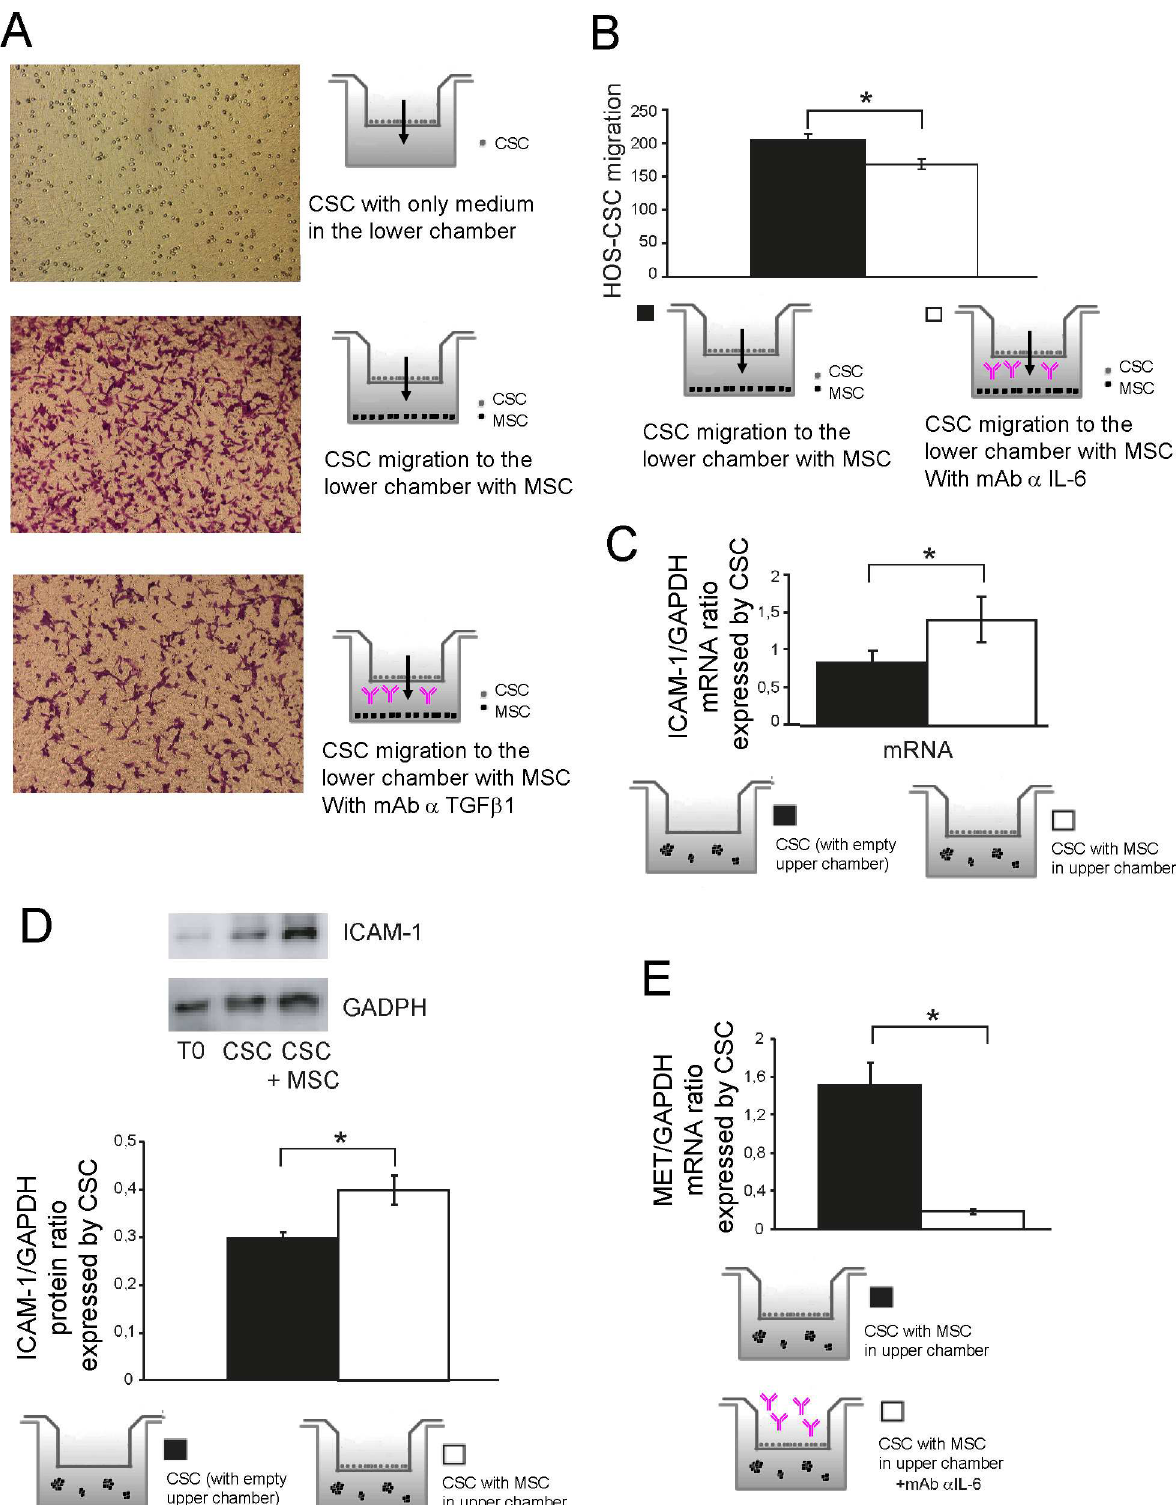
Fig 8. Stromal cells enhance HOS-CSC migration via IL-6 and the expression of adhesion molecules. (A) We assessed whether treatment with Tocilizumabaffected HOS-CSC migration. MSC were treated with Tocilizumab [100 μ g/mL] 2 hours prior CSC